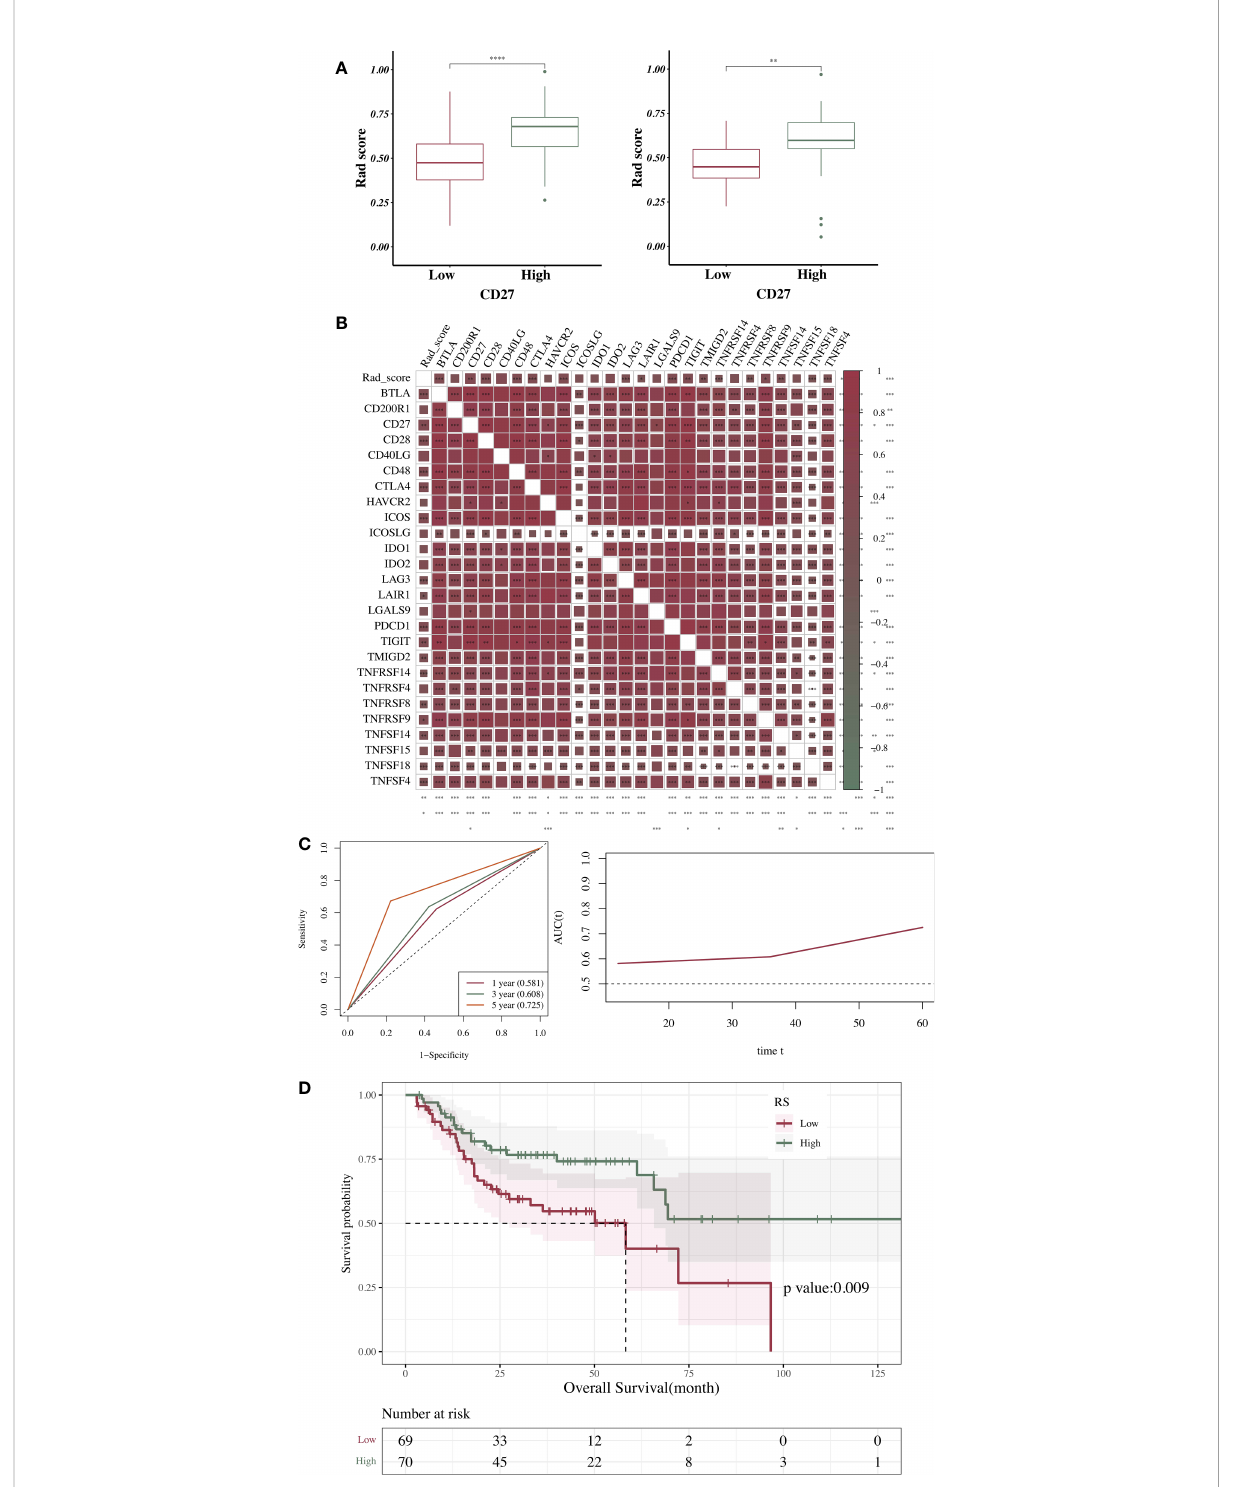
FIGURE 4 Association between RS and clinical characteristics. (A) Association between RS and CD27 expression. (B) Correlation analysis of RS, CD27 expression, and expression of immune genes expression. (C) Time-dependent ROC curve obtained according to the AUC value of the main variable at each time point (12, 36, and 60 months). (D) Correlations between RS and OS in HNSCC. * p < 0.05, ** p < 0.01, *** p < 0.001, ****p <